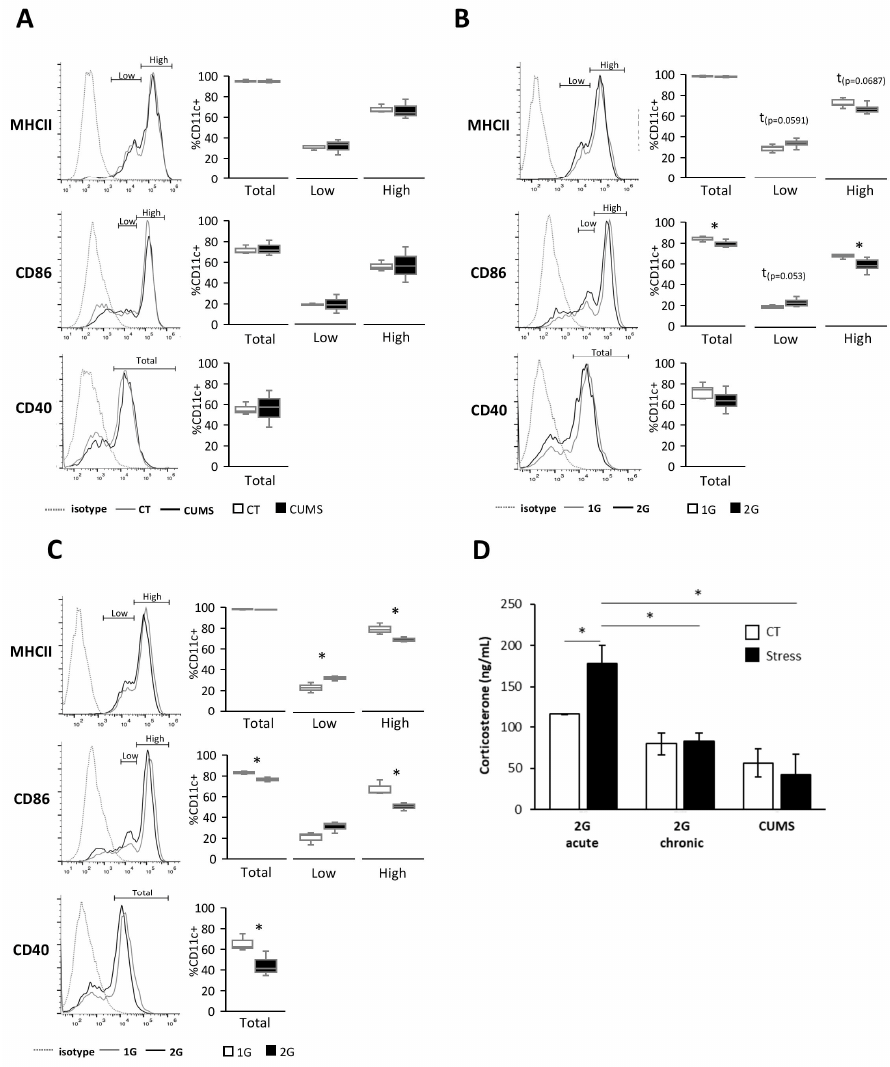
Figure 1. Acute and chronic hypergravity stresses affect the splenic DC phenotype independently of glucocorticoid level. ( A – C ) Splenic DCs were isolated from mice and cultured for 24h with se- rum from control mice (CT) or mice exposed to CUMS (CUMS) ( A ), chronic ( B ), or acute hyper- gravity ( C ) stresses. Cells were then analyzed by flow cytometry for the expression of MHCII, CD86, and CD40. Representative FACS histograms are shown of populations that express either total or low/high levels of the related marker (left panel), and box plots are shown of the median percent of CD11C gated cells expressing MHCII, CD86, or CD40 (right panel). The boxes extend from the 25th to the 75th percentile; whiskers indicate the minimum and maximum. Data are from one experiment with n = 3 serums/group ( A ), three independent experiments with n = 3 se- rums/group/experiment (B), and two independent experiments with n = 3 serums/group/experi- ment ( C ). ( D ) Mean ± SEM of corticosterone levels measured by ELISA in serum from mice sub- mitted to chronic ( n = 8) or acute ( n = 3) hypergravity or CUMS ( n = 3) stresses. T-test, Mann–Whit- ney, or ANOVA tests were used to reveal statistically significant differences. * p < 0.05, t indicates a tendency.